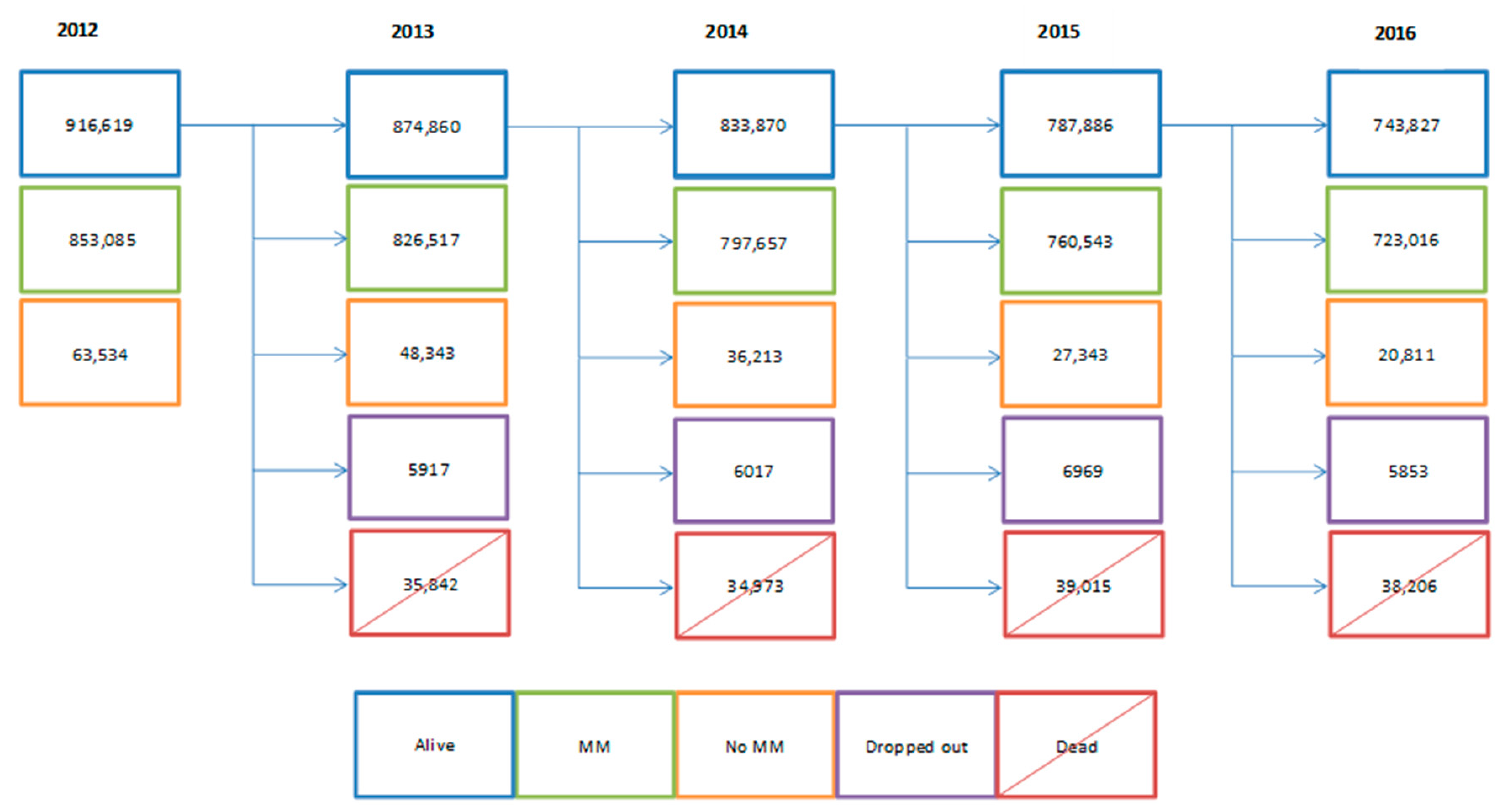
Figure 1. Longitudinal flow chart of patients meeting initial inclusion criteria, without consideration for the multimorbidity criterion (2012–2016; N = 916,619